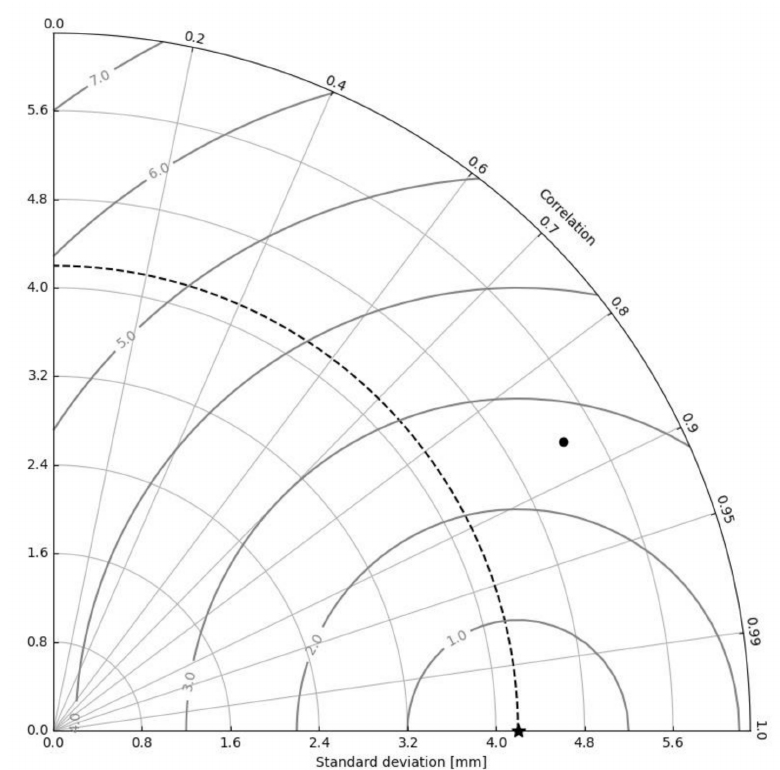
Figure 5. Example of Taylor diagram as used in the paper. The point represented by a star ( (cid:70) ) corresponds to the observation-derived time series X o ( k ) . It is plotted along the abscissa axis using its standard deviation (i.e., σ o = 4.2 mm). The point corresponding to the model-derived time series X m ( k ) is represented by a bullet ( • ). The radial distance from the origin to this point is proportional to the standard deviation of X m ( k ) (i.e., σ m = 5.3 mm). The labeled circles measure the distance from the star (cid:70) and thus the Centered RMS difference between the two time series (i.e., D = 2.6 mm). The radial lines are labeled by the correlation coefficient between the two time series (i.e., R =